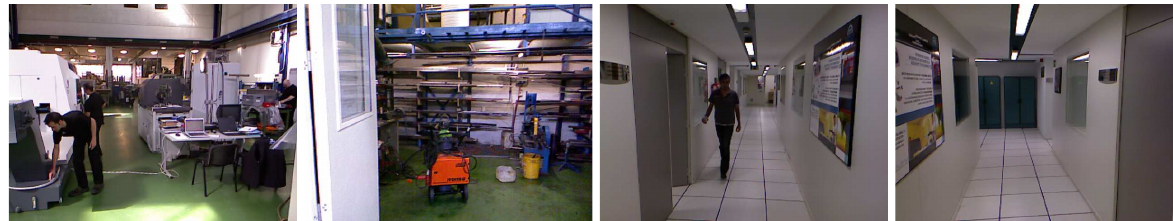
Figure 11. Respectively, a true positive, false positive, false negative and true negative example using our approach.